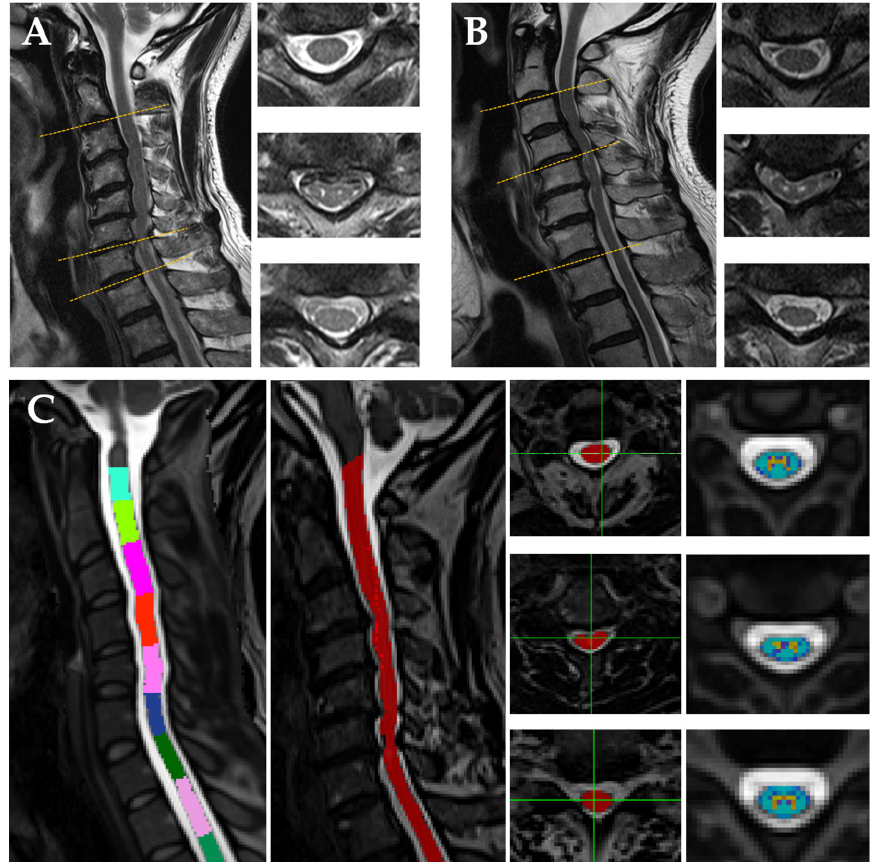
Figure 1. Examples of sagittal and axial slices at each level in two patients. The maximum compres- sion level is at the C6/7 ( A ) and at the C4/5 ( B ). Panel ( C ) shows vertebral labeling, cord area at each level, and white matter/gray matter segmentation of patient A. More details concerning data processing are presented below.